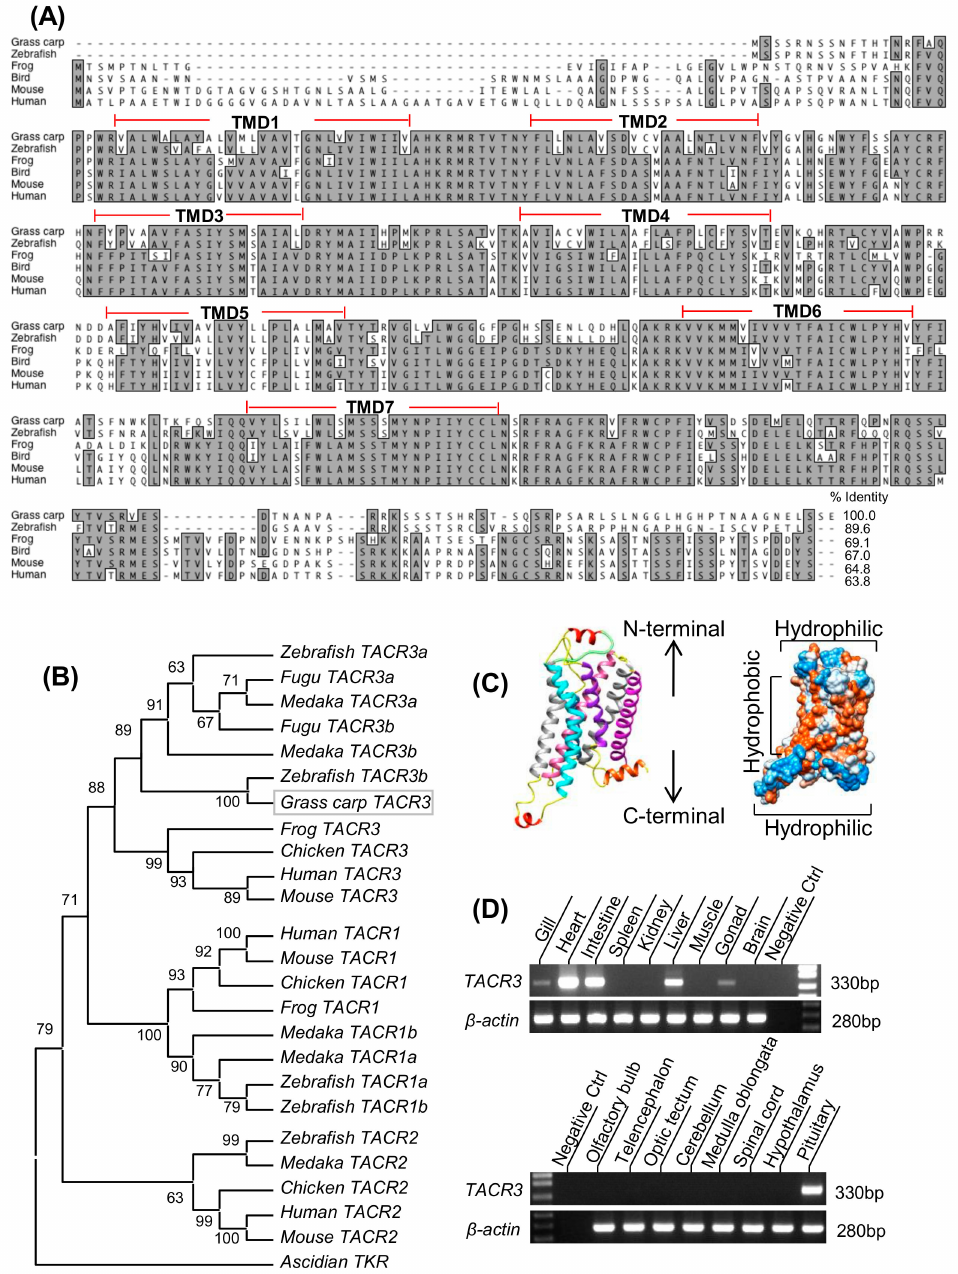
Figure 1. Molecular cloning and tissue distribution of grass carp TACR3: ( A ) Amino acid sequence alignment of grass carp TACR3 using the Clustal-W algorithm with the Mac Vector program. The conserved amino acid (a.a.) residues are boxed in grey, and the seven transmembrane domains are labeled as TMD1–7. ( B ) Phylogenetic analysis of tachykinin receptors nucleotide sequences using neighbor-joining method with MEGA 6.0: Ascidian TKR was used as an out-group. ( C ) Three-dimensional protein model of grass carp TACR3 was deduced based on the crystal structure of human TACR3 using the SWISS-MODEL program. The location of N-terminal and C-terminal were highlighted. ( D ) Tissue distribution profile of grass carp TACR3: Total RNA was isolated from selected tissues and various brain regions in grass carp and subjected to RT-PCR using a primer specific for grass carp TACR3. β -actin was used as the internal